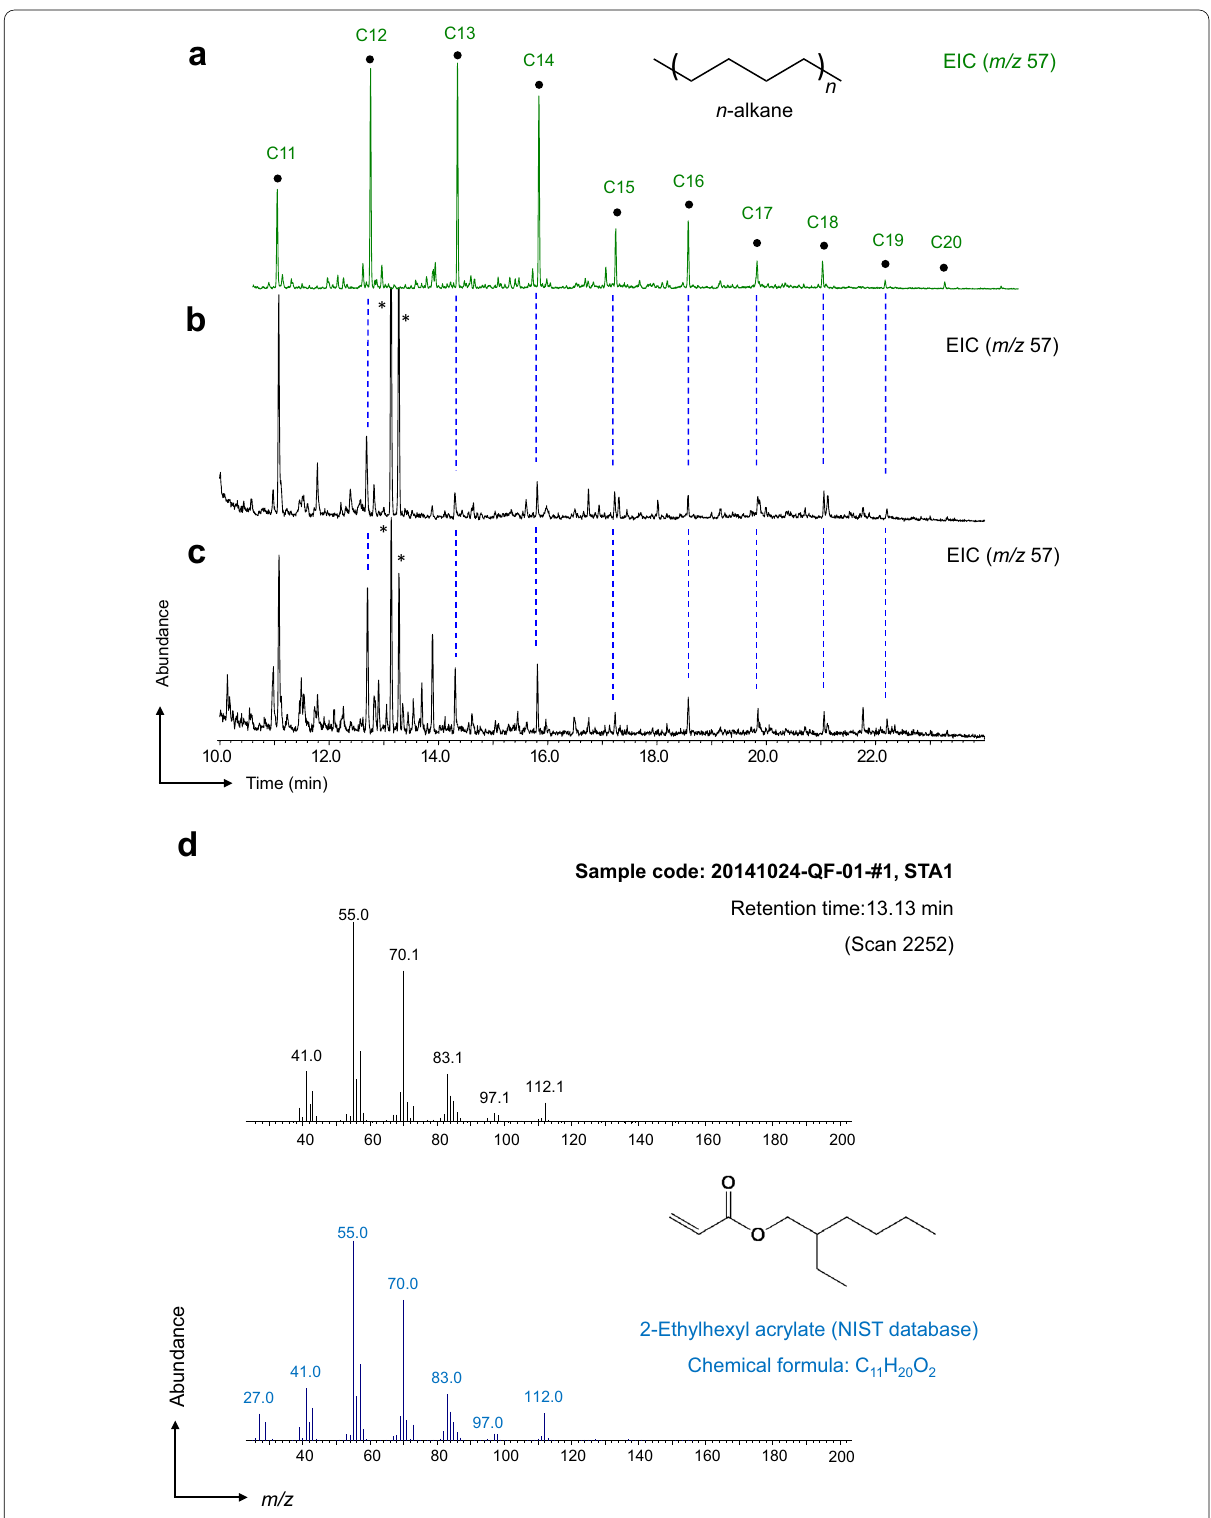
Fig. 6 (See legend on previous